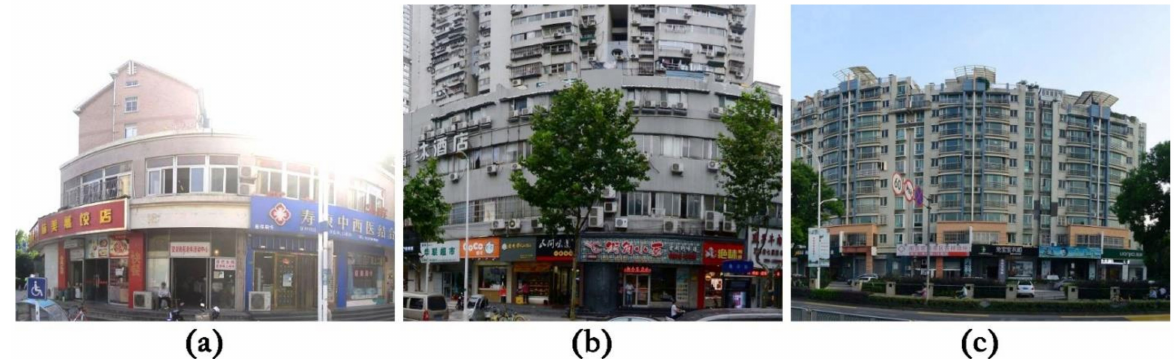
Figure 15. Some examples from street view images show the limitations of the proposed method. ( a ) Despite the color calibration, color deviations remain in the overexposed street view image. ( b ) The residential building with commercial service is not easy to identify. ( c ) The building in the street view photo tends to be a residential house, while the label from the OSM user is a